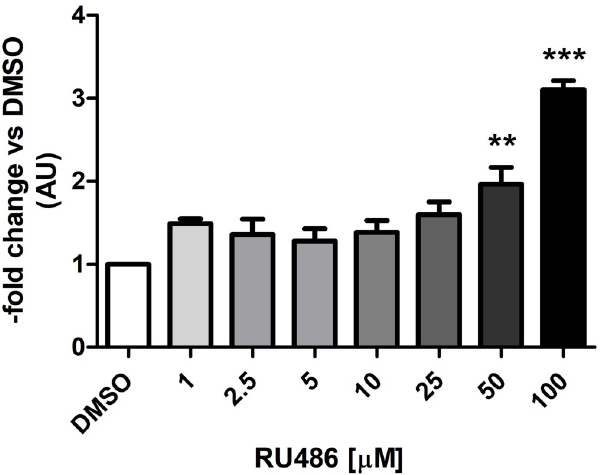
Fig 7. Induction of CYP3A28 mRNA in BFH12 cells exposed to increasing concentrations of RU486 for 6 hours. BFH12 cells were treated with different concentrations of RU486 (1, 2.5, 5, 10, 25, 50 and 100 μ M) for 6 hours, as described in Materials and Methods. The expression of CYP3A28 was detected by qPCR in control (0.1% DMSO) and treated cells, using RPLP0 as internal control gene. The relative expression of DMSO-treated cells was set to 1 and its value was used for the normalization of the other groups. Data are expressed as the mean ± SD of three independent experiments (arbitrary units, AU). Statistical analysis: ANOVA + Tukey’s post test. Significance was defined as: P < 0.01: �� , DMSO vs . 50 μ M RU486; P < 0.001: ��� , DMSO vs . 100 μ M